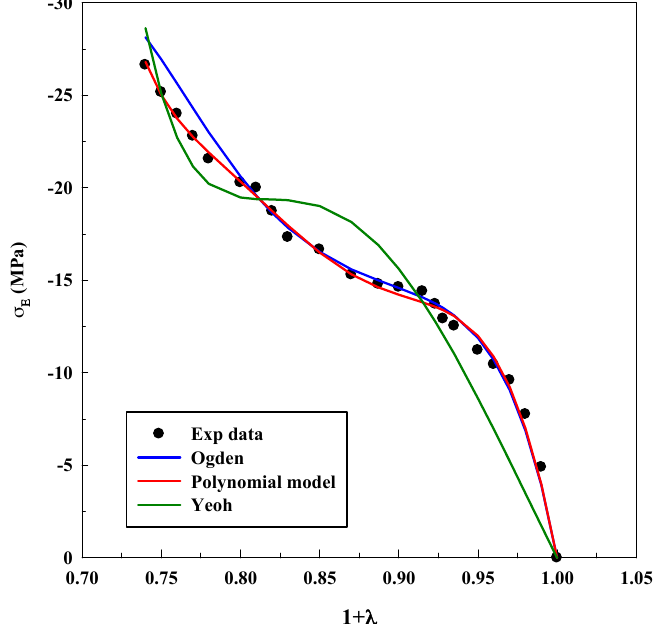
Figure 10. Fitting of compression tests for the system CA loaded with 3% w / w GO using different models.